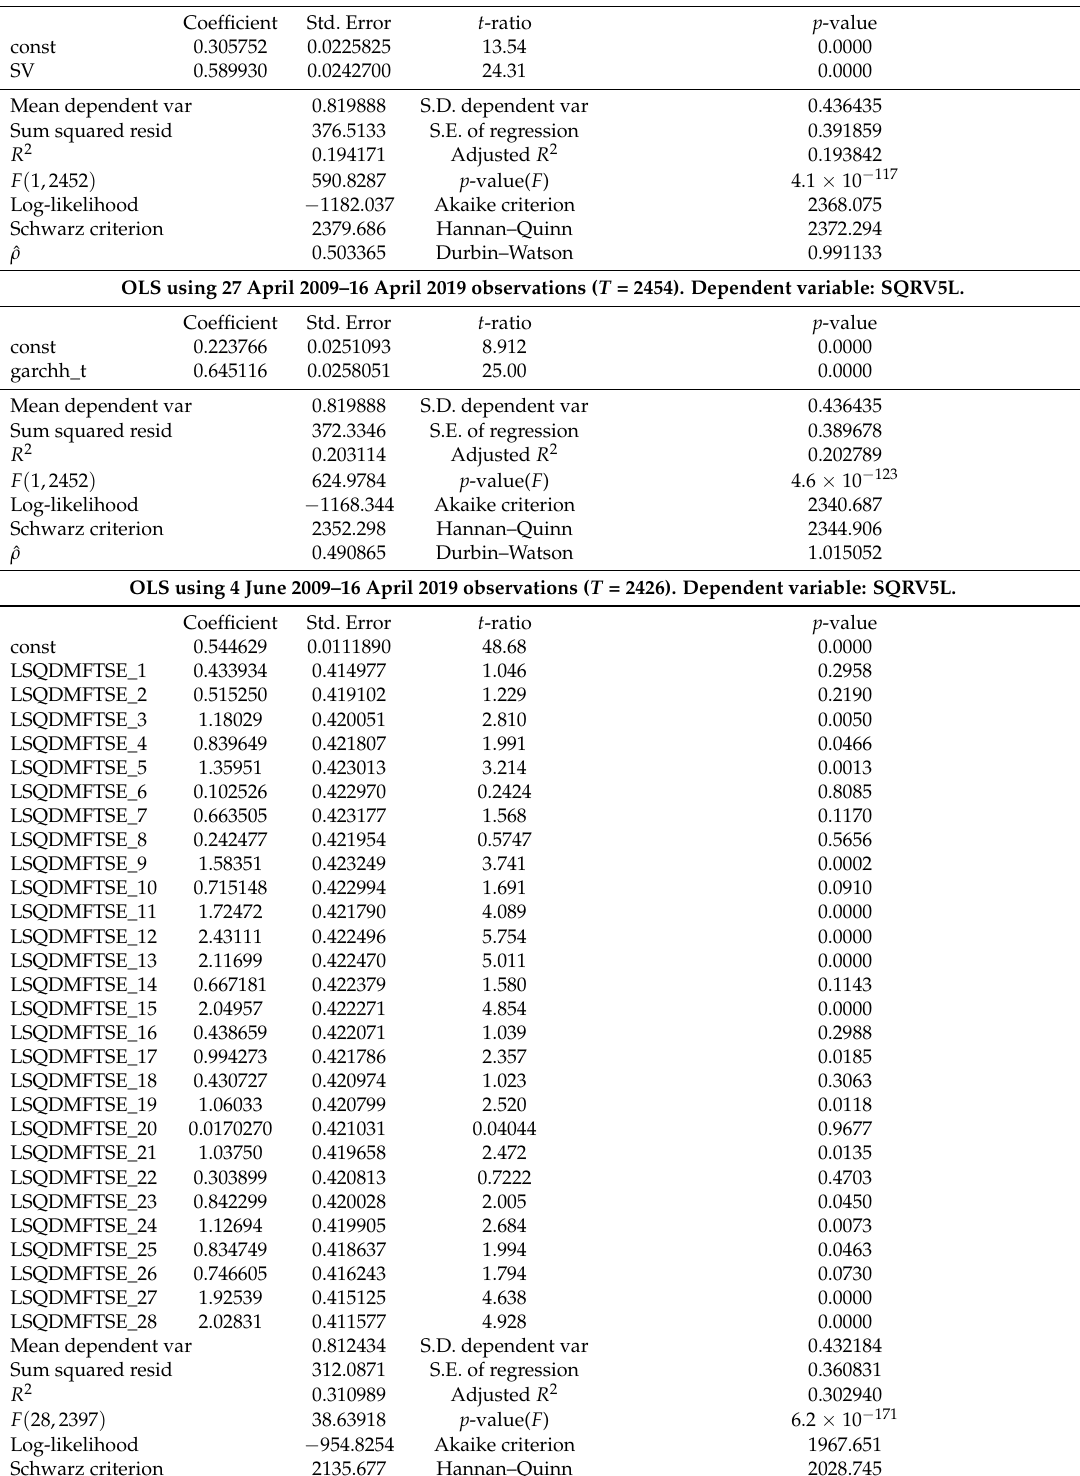
Table 5. Regression analysis of three volatility models: SV, GARCH(1,1), and lagged demeaned squared